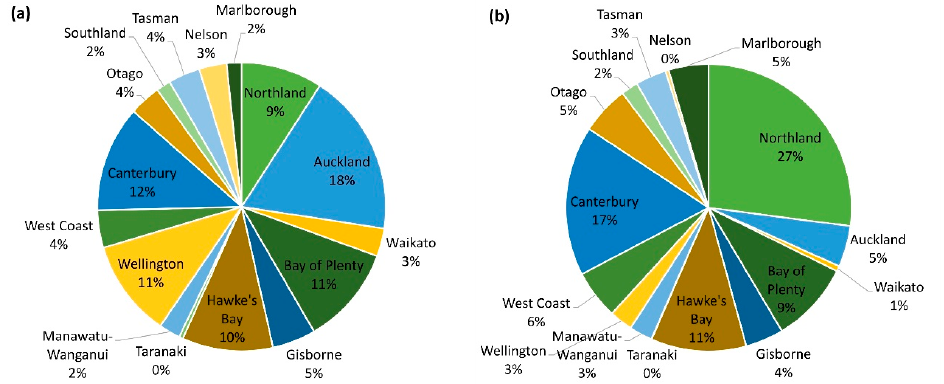
Figure 5. Proportional distribution by region for ( a ) built-up and ( b ) primary production land exposure in tsunami evacuation zones.